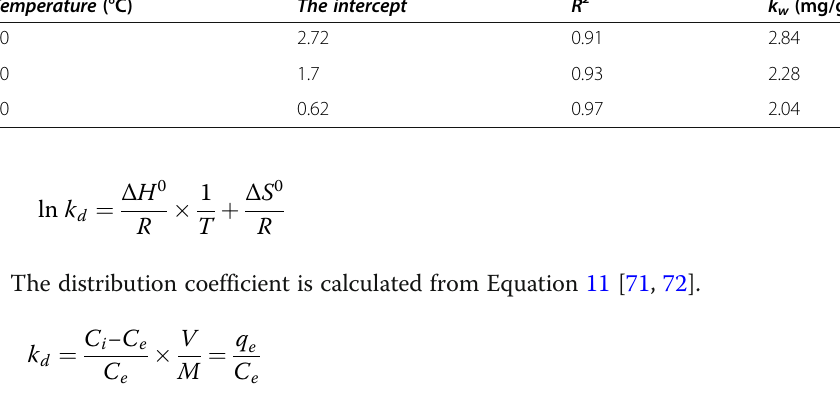
Table 4 Values of transport parameters Temperature (°C)